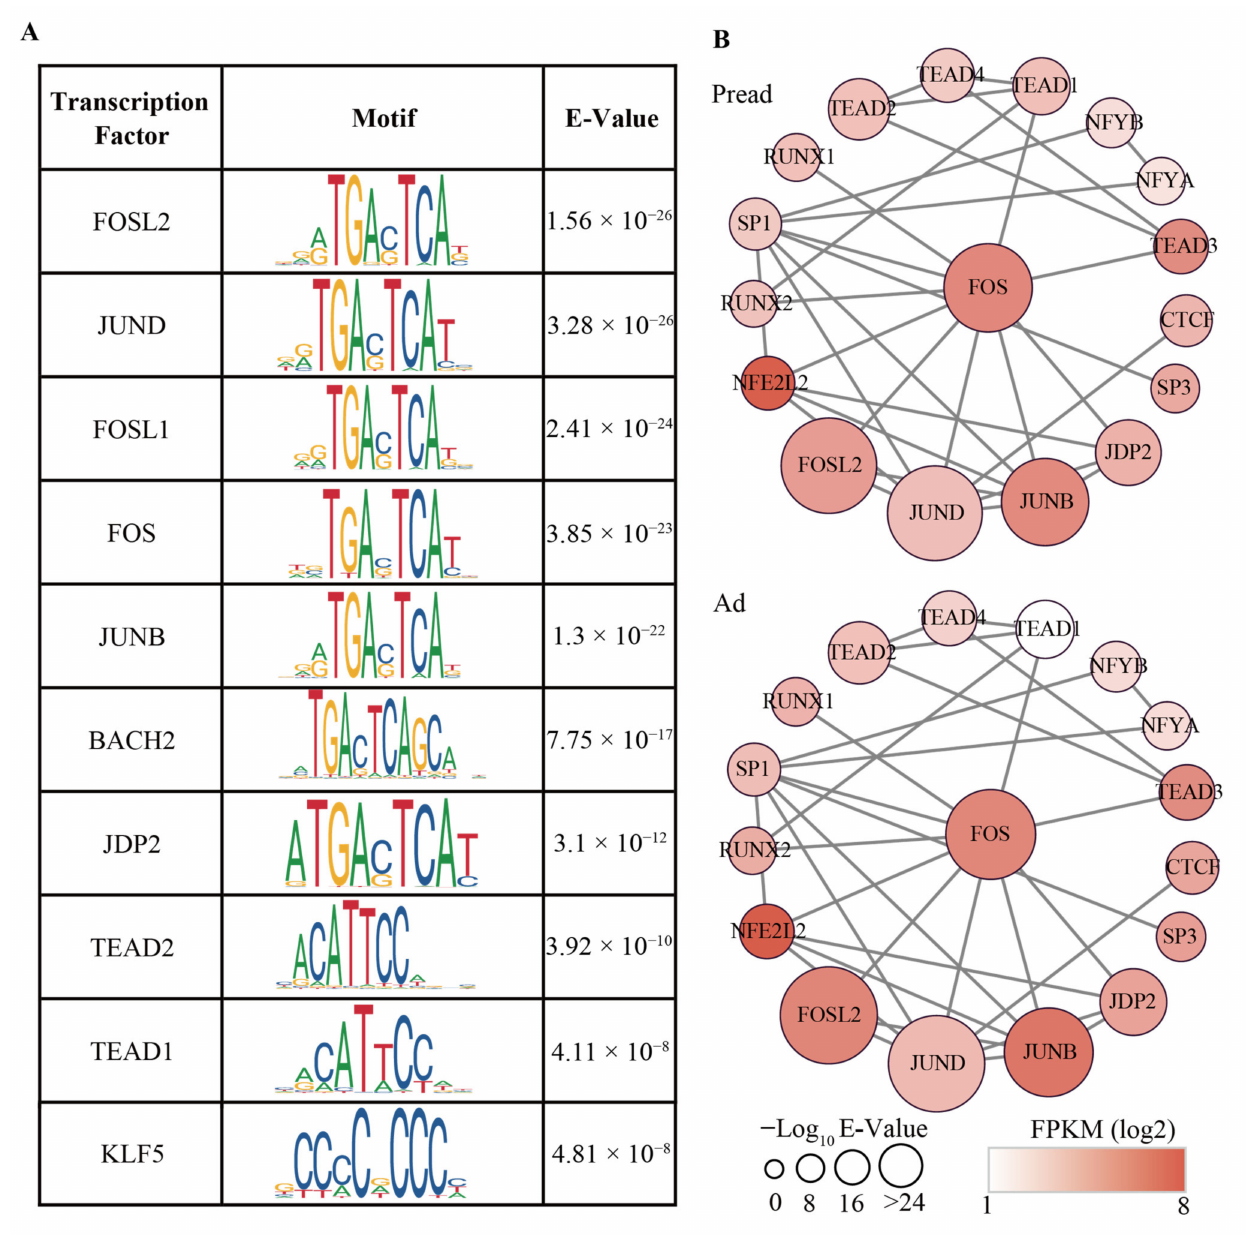
Figure 5. Transcriptional regulatory network during adipocyte differentiation. ( A ) Top ten tran- scription factors enriched in motifs of differential accessible peaks. The E-value is the adjusted p -value multiplied by the number of motifs in the motif file. ( B ) The interaction network between transcription factors. The size of the nodes represents the E-value of the significance. The color of the nodes represents expression levels (FPKM) of